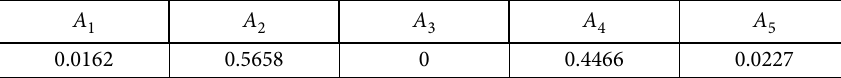
Table 10. The weighted NDA of the enhancement EDAS method based on the PT 1